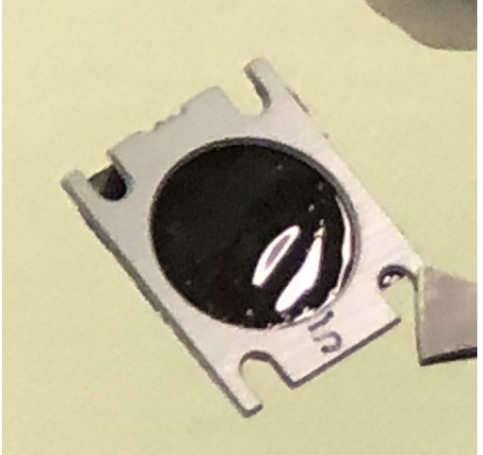
Fig. 3 nat Ir-loaded graphene target, 0.6 mg/cm 2 , after beam